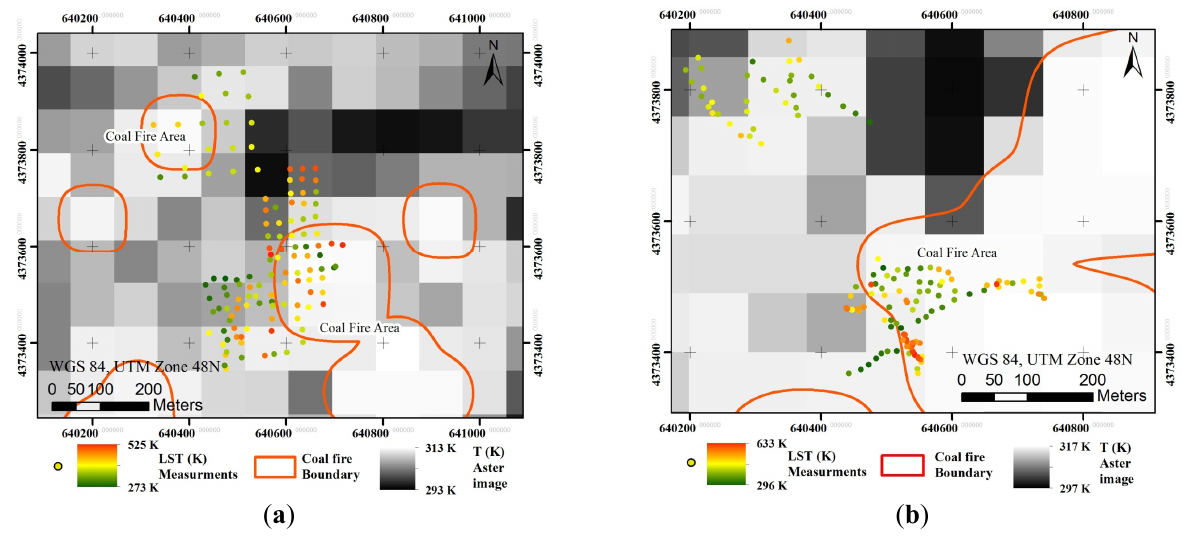
Figure 6. Hypothesis testing layout showing sets of points from ( a ) 27 March 2013 and ( b ) 22 June 2013. Points were measured inside the coal fire area (high temperature group) and outside the fire area (low temperature